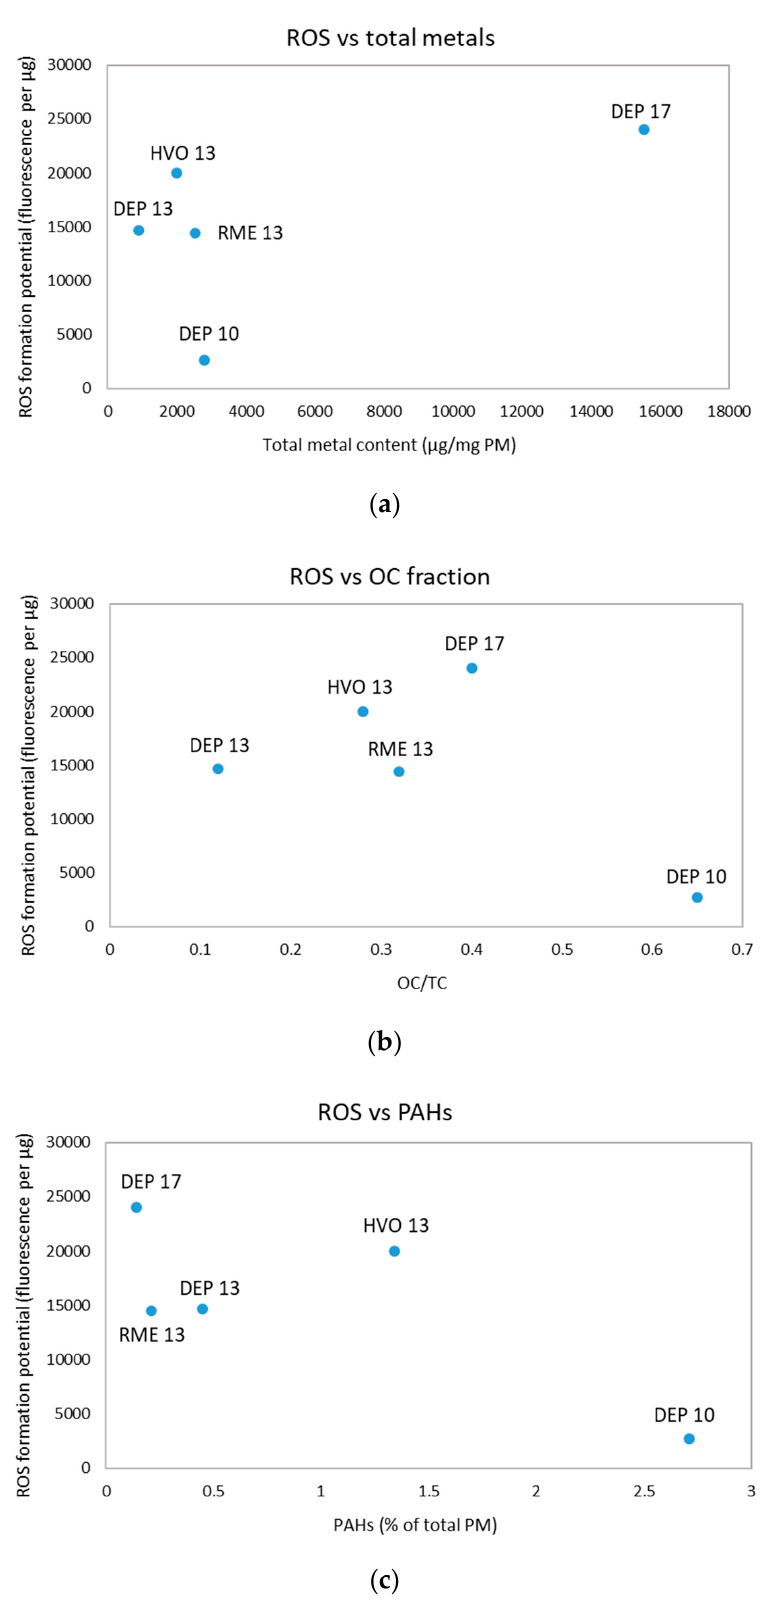
Figure A6. The ROS formation potential per mass versus the ( a ) total metal content. ( b ) the OC/TC fraction and ( c ) total PAH concentration. No clear relationship was found for these parameters to ROS formation potential.